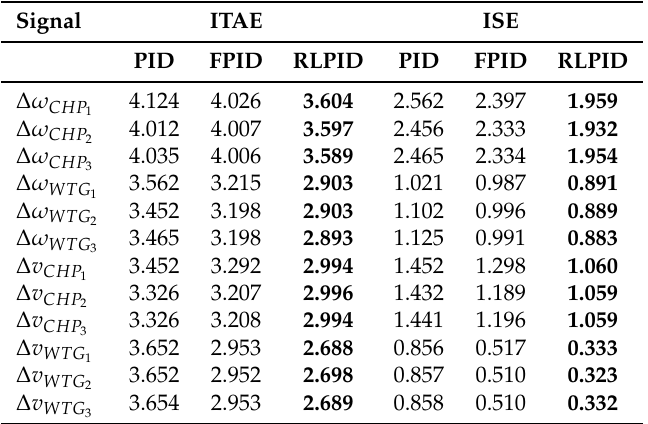
Table 3. Time domain performance indices in scenario 2.